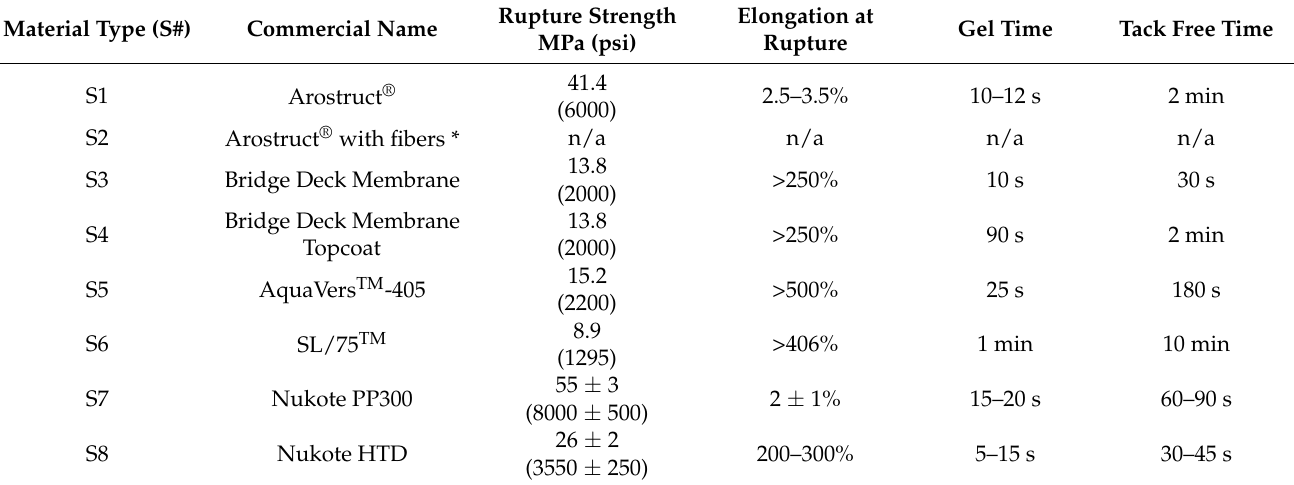
Table 1. Properties of polyurea used in the study based on the manufacturer’s datasheet.